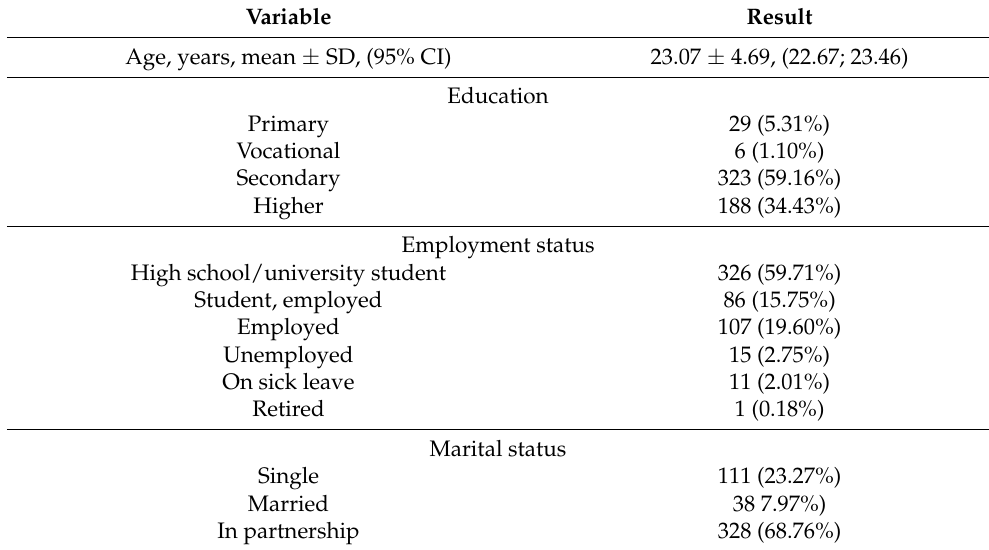
Table 1. Characteristics of the group (N =